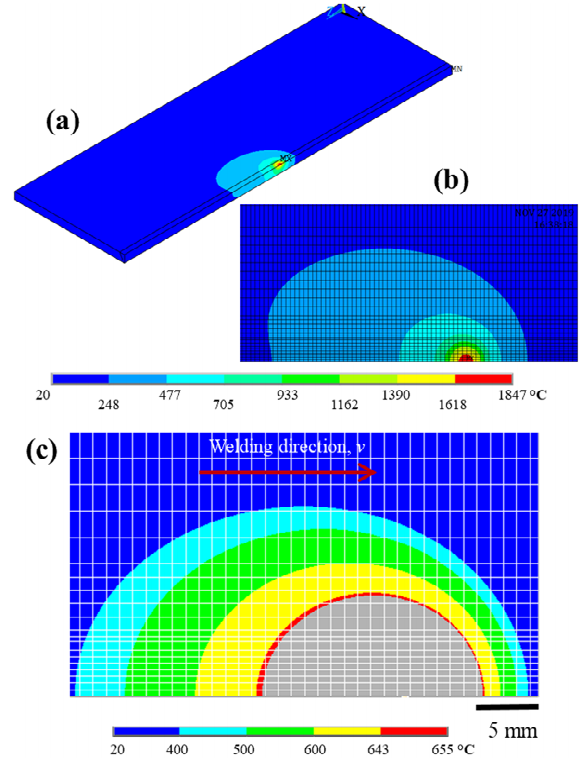
Figure 12. Temperature contours in the pseudo-steady state condition during the 3003-H14 welding: ( a ) general view of the isotherms (half model), ( b ) detailed view of the isotherms showed in ( a ), and ( c ) contours for the fusion–solidification temperatures as well as the contours of 600 °C, 500 °C, and 400 °C temperatures. Metals 2020 , 10 , x FOR PEER